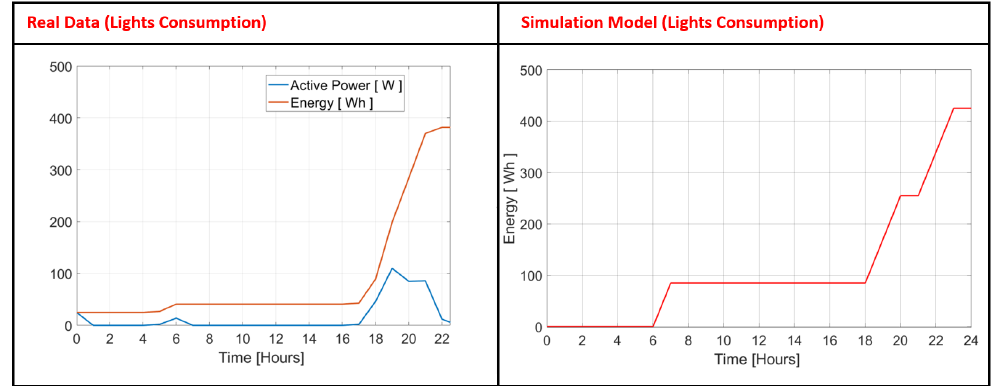
Figure 10. Real data vs. Simulation model (Lights), the red line represents the energy consumption in both graphs [Wh].